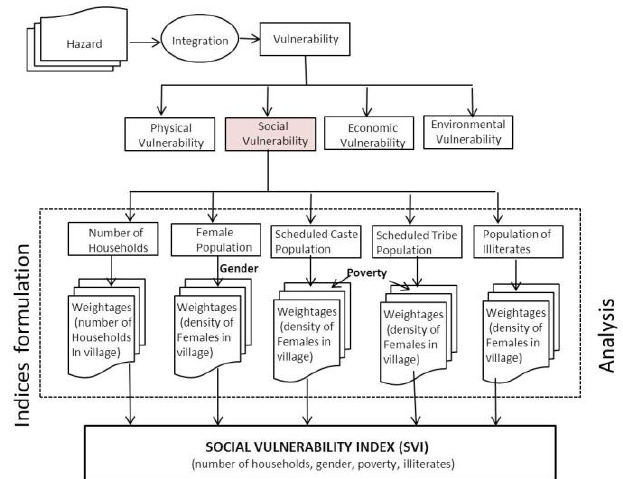
Figure 2: Flow chart showing the methodology to derive Social Vulnerability